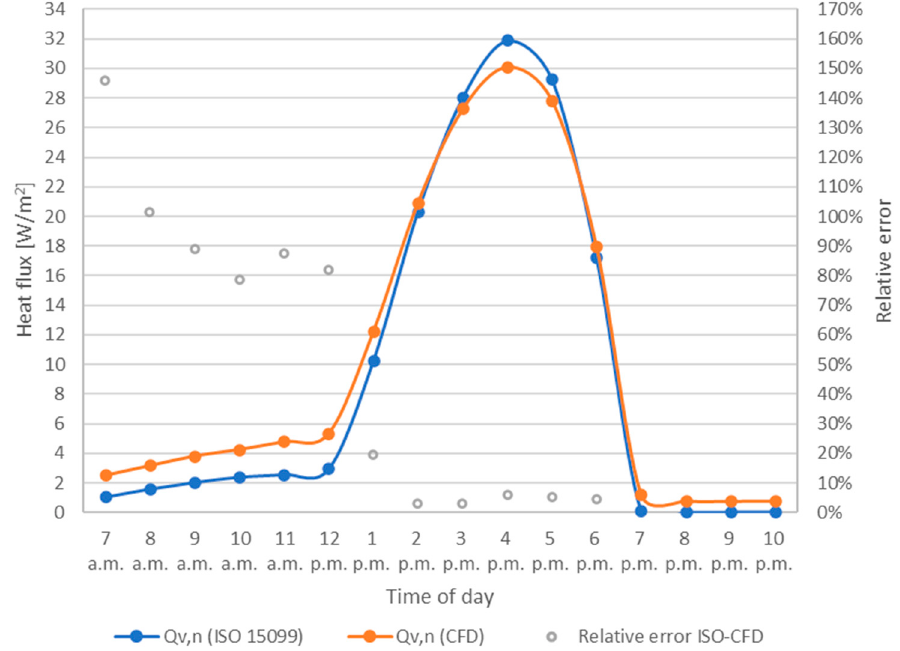
Figure 13. Comparison between the heat flux removed from the cavity by natural ventilation (Q v,n ) calculated according to ISO 15099 and CFD simulations. The graph shows also the RE of the CFD compared to the standard, calculated until 6:00 p.m. local results.